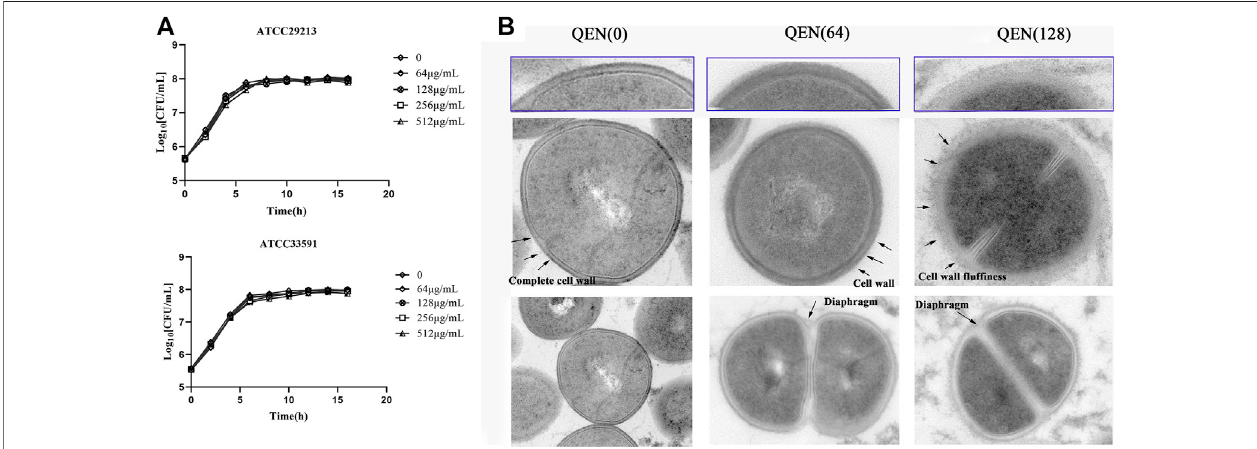
FIGURE 6 | Effect of different concentrations of QEN on growth of the different bacterial strains S. aureus . (A) Effect of QEN on the growth of the two bacterial strains S.aureus ,indicatingthatgrowthisnotaffectedattheconcentrationused (B) EffectofQENonthesubcellularorganellesofthestrainWLD10,indicatingthatQEN counld trigger the sparseness of the S. aureus cell wall structure, but the division and proliferation.